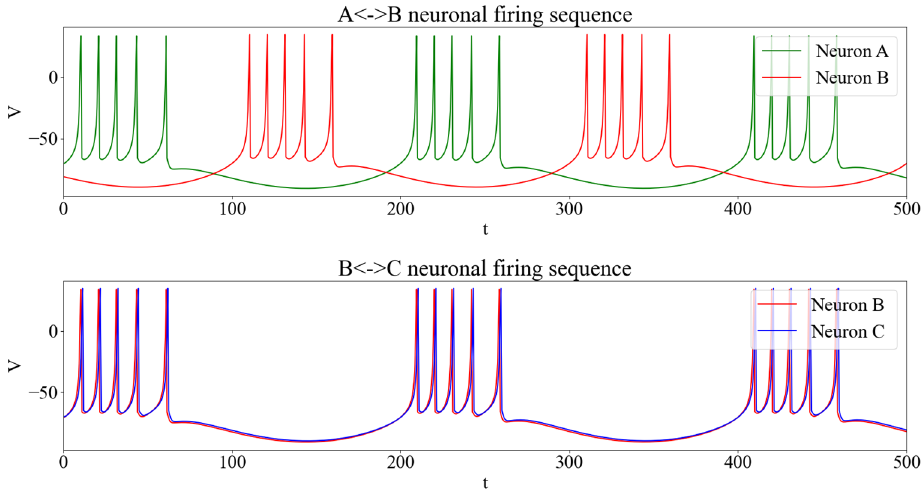
Figure 5. The discharge sequence of three neurons connecting model 1(b-2).